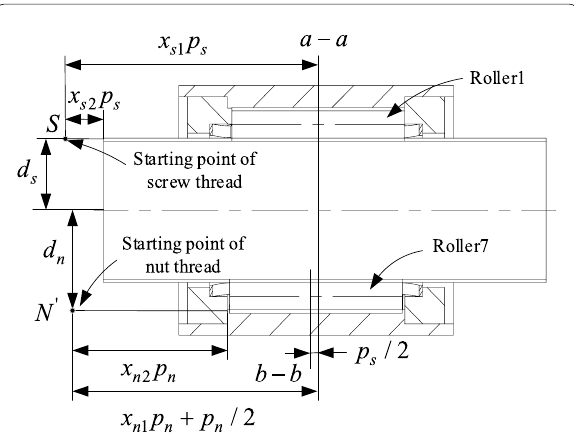
Figure 14 Diagram of screw and nut assembly